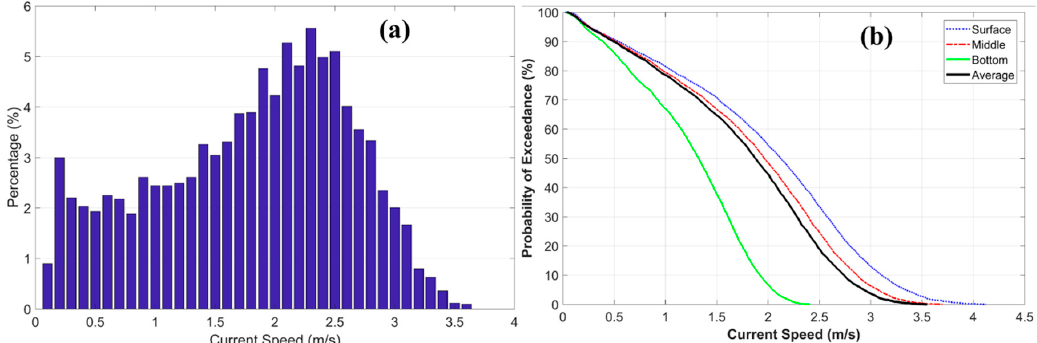
Figure 11. ( a ) histogram plot of current speed at the middle depth of Station COI0503 over the three months of model simulation in summer 2005; ( b ) the corresponding cumulative frequency distribution plots of current speed over various water depths.